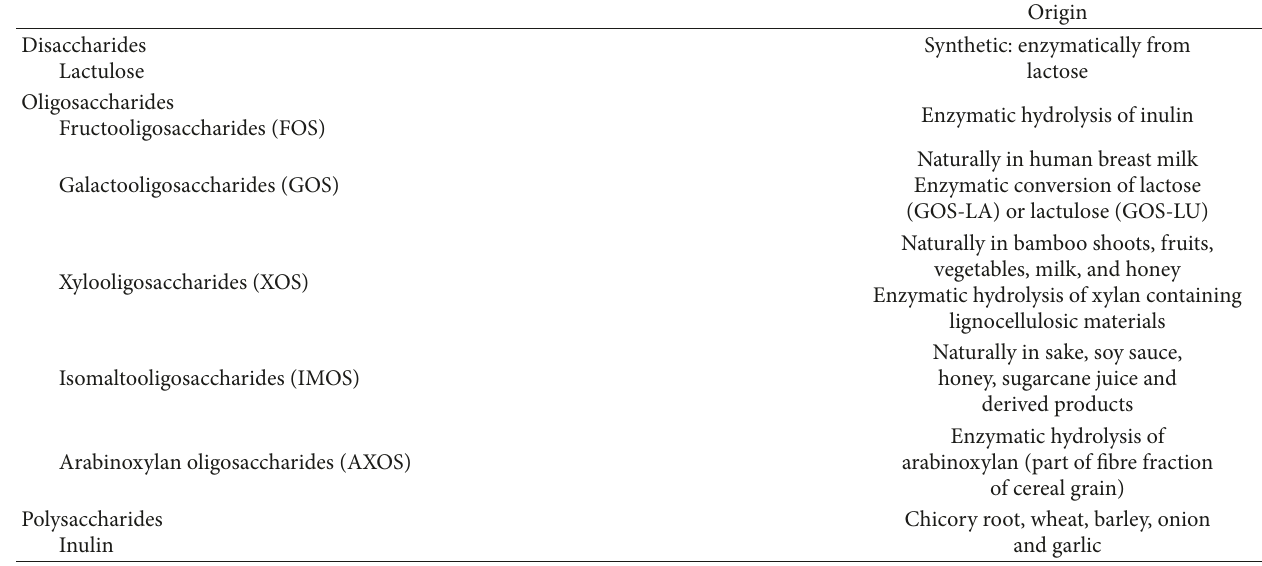
Table 1: Classification of potential prebiotics [34].